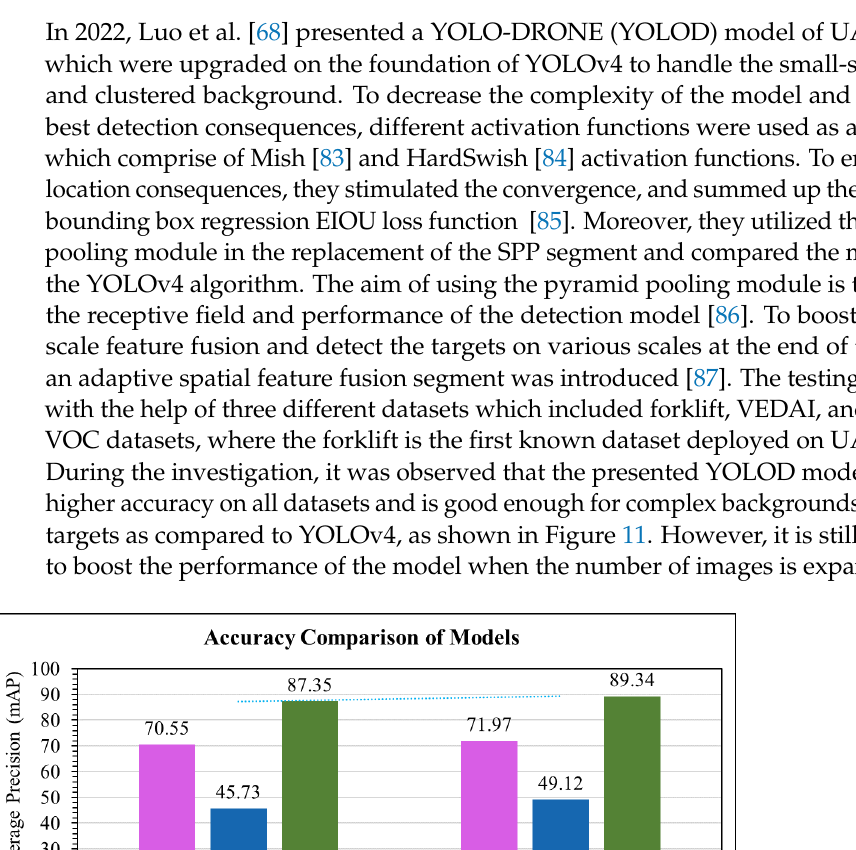
Figure 10. Average precision of YOLOv4_Drone approach based on different target classes.